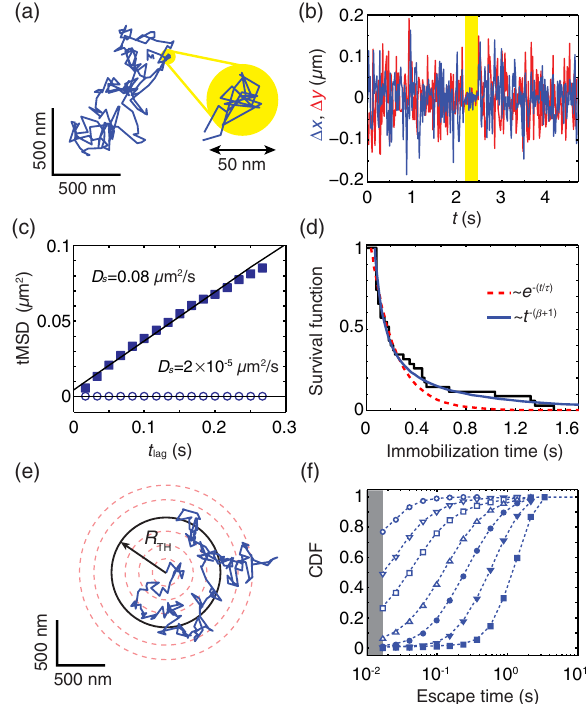
FIG. 2. DC-SIGN receptor dynamics is inconsistent with the CTRW model. (a) A trajectory of WT DC-SIGN on living-cell membranes showing a short-lived transient immobilization event, highlighted by the yellow circular area. (b) Plot of the x (blue) and y (red) displacements as a function of time. The occurrence of transient immobilization (yellow region) corresponds to a reduc- tion in the trajectory displacement. (c) Time-averaged MSD for the entire trajectory (filled square) and for the immobilization region only (open circle). (d) Survival function of the duration of immobilization events for WT DC-SIGN trajectories (black line). Red and blue lines correspond to fits to exponential and power- law distribution functions, respectively. The power-law fit pro- vides β ¼ 0 . 83 (cid:3) 0 . 05 , in agreement with the exponent obtained for the eMSD. (e) Schematic representation of the calculation of the escape-time probability from circular areas of different radius R . (f) CDF of the trajectory escape time for different radii TH R 20 (open circle), 50 (open inverted triangle), 100 (open TH ¼ square), 200 (open triangle), 300 (filled circle), 500 (filled inverted triangle), and 1000 (filled square) nm. Dashed lines are guides to the eye. The gray-shaded region represents times shorter than the acquisition frame